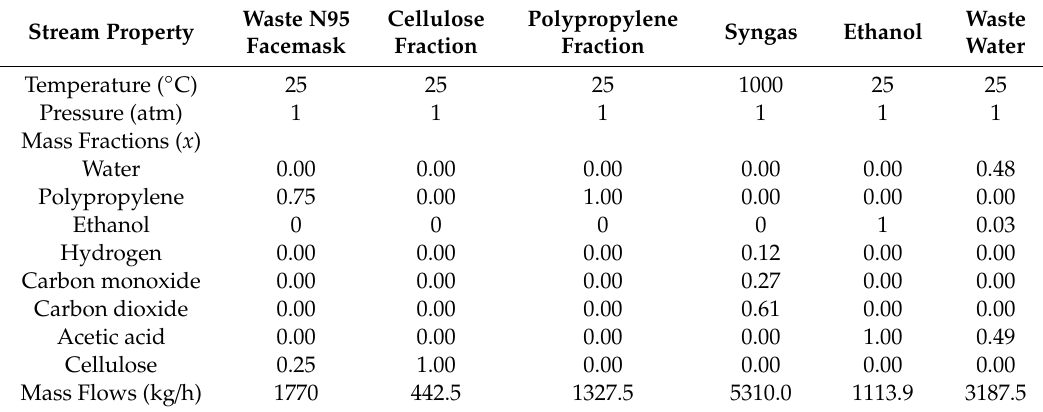
Table 6. Mass balance results for major streams in the process for waste N95 facemask syngas fermentation for ethanol production (scenario